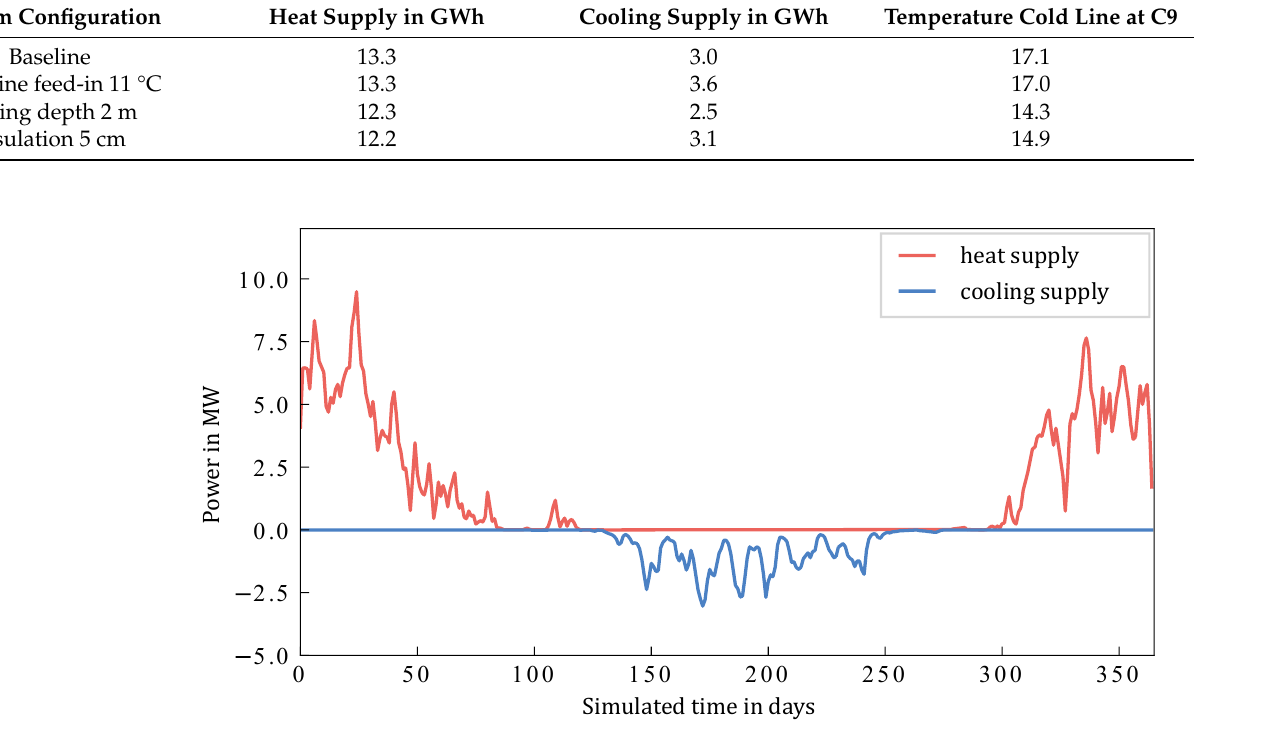
Figure 16. Central heat and cooling supply (S1) in baseline scenario.